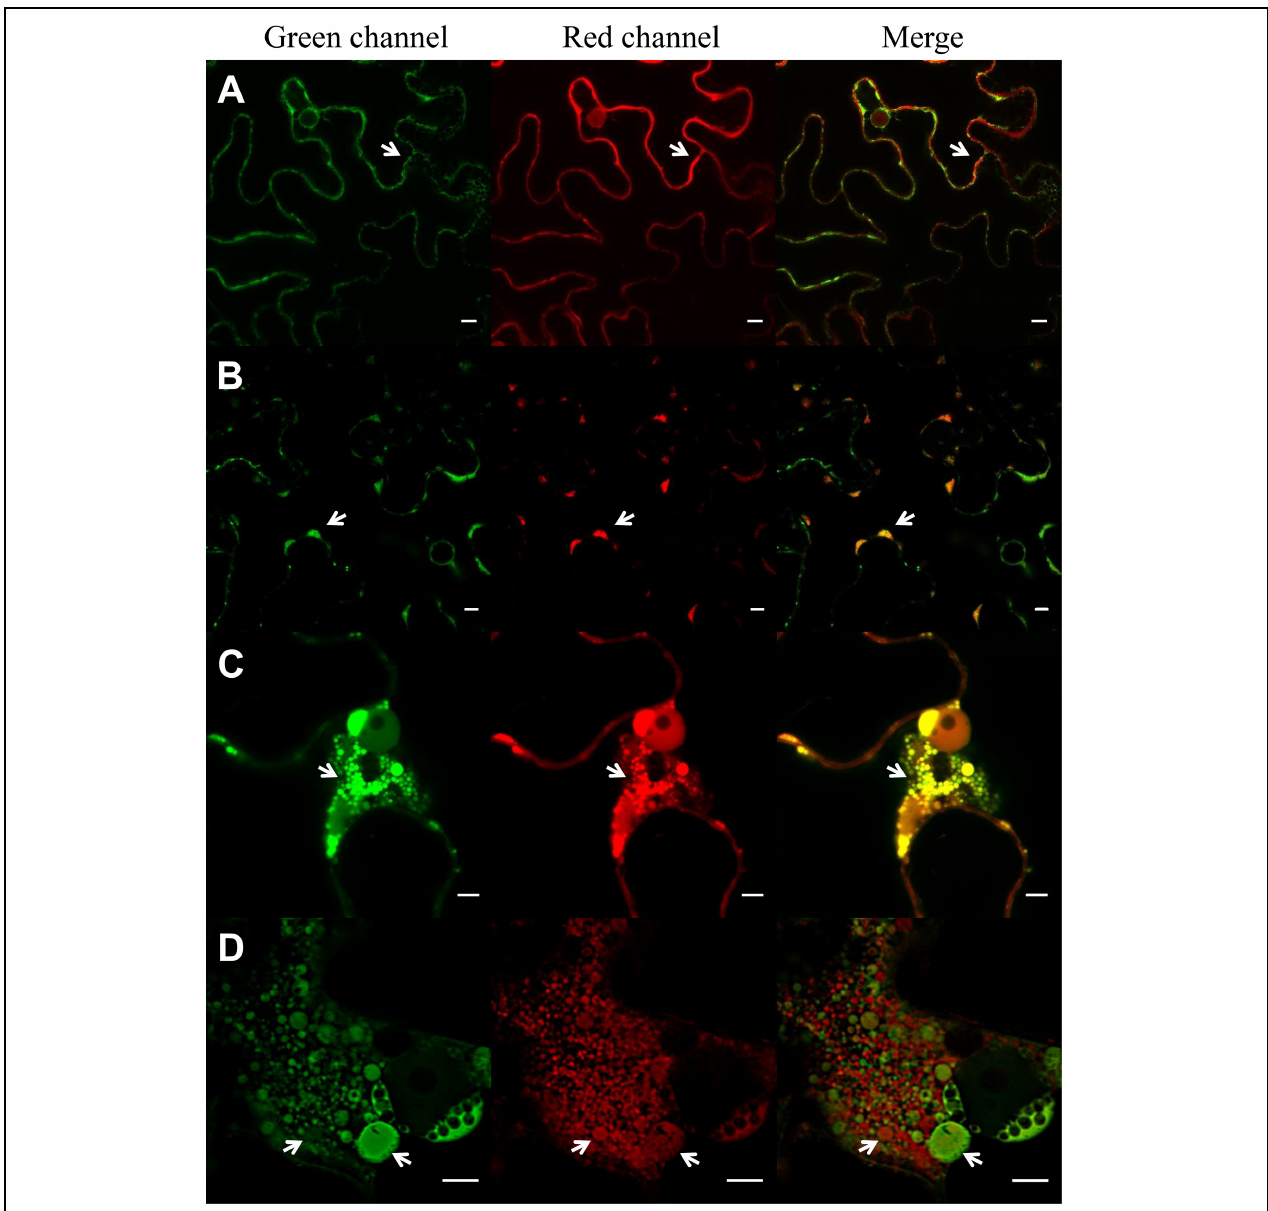
FIGURE 2 | Induction of protein bodies by expression of ELP. Expression of ER-GFP and sec-RFP (A) , ER-RFP-TG2 and ER-GFP (B) , ER-GFP, sec-RFP and ELP (C) , ER-RFP-TG2, ER-GFP and ELP (D) in N. benthamiana leaf epidermal cells. ER-GFP shows the typical ER reticulated pattern (green channel, A ), sec-RFP has an irregular pattern on the borders of the cell typical of apoplast (apo; red channel, A ), no co-localization of ER-GFP and sec-RFP is observed in the merge panel. ER-RFP-TG2 (B) is mainly located in clusters (PB) in the borders of the cells (arrows), and the signal on the rest of the ER network is low. Co-localization of ER-RFP-TG2 and ER-GFP is observed mainly in these clusters ( B , merge). ELP expression induces protein body formation (PB) in (C,D ). Co-localization of ER-GFP and sec-RFP is observed in PB ( C , merge) while RFP-TG2 did not entirely colocalize with ER-GFP ( D , merge) in the nuclear region of the cell. Scale bars: 10 μ m (A,B) and 5 μ m (C,D)